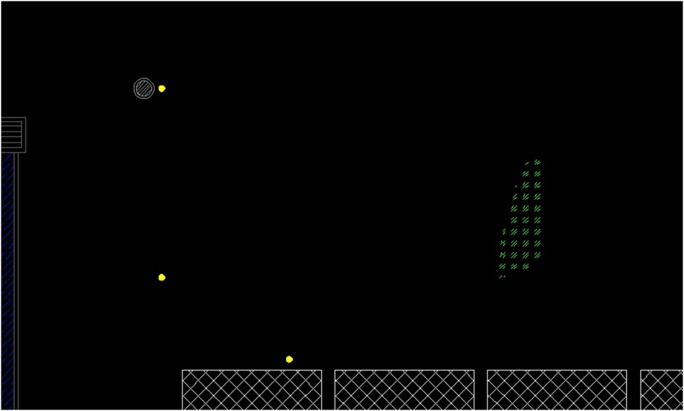
Piling Activity.